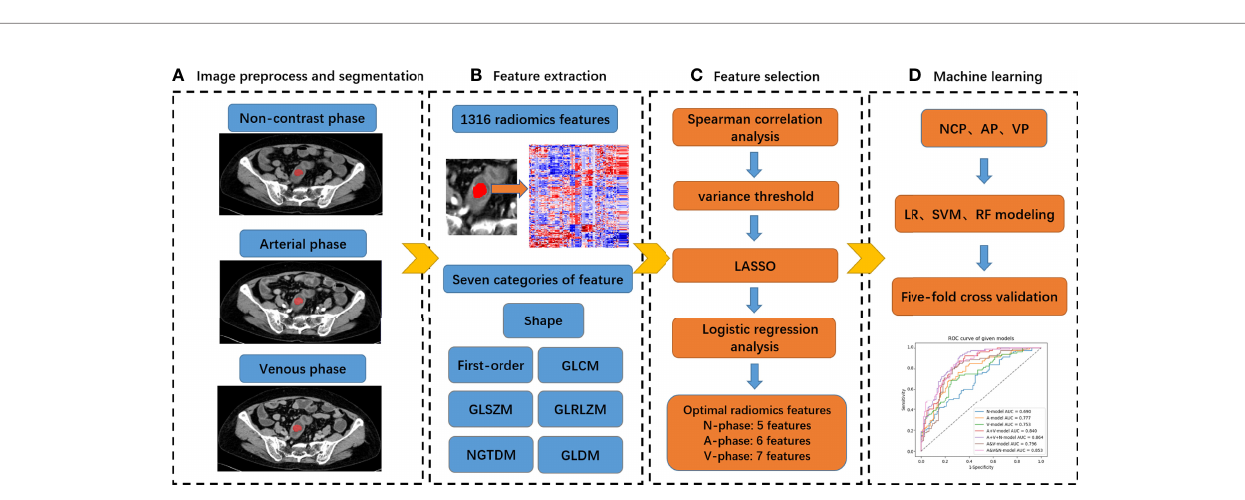
FIGURE 2 | Radiomics analysis work fl ow of our study.